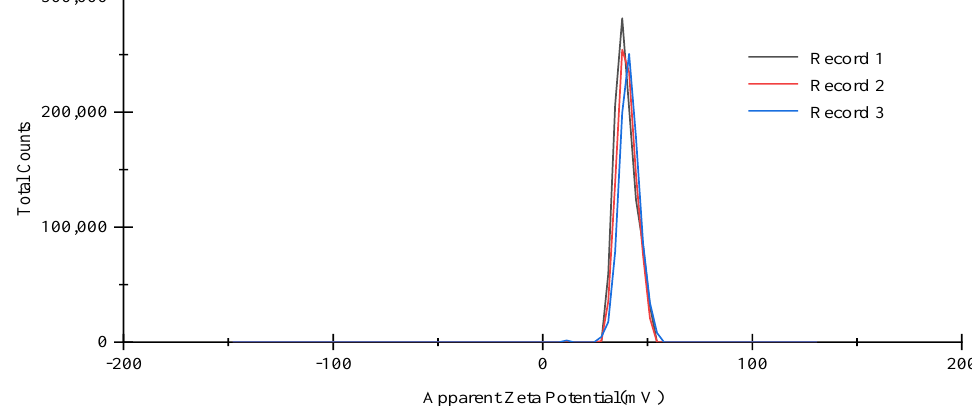
Figure 4. OEO- CSNPs zeta potential. Records 1−3 represent the first few repetitions of the experiment